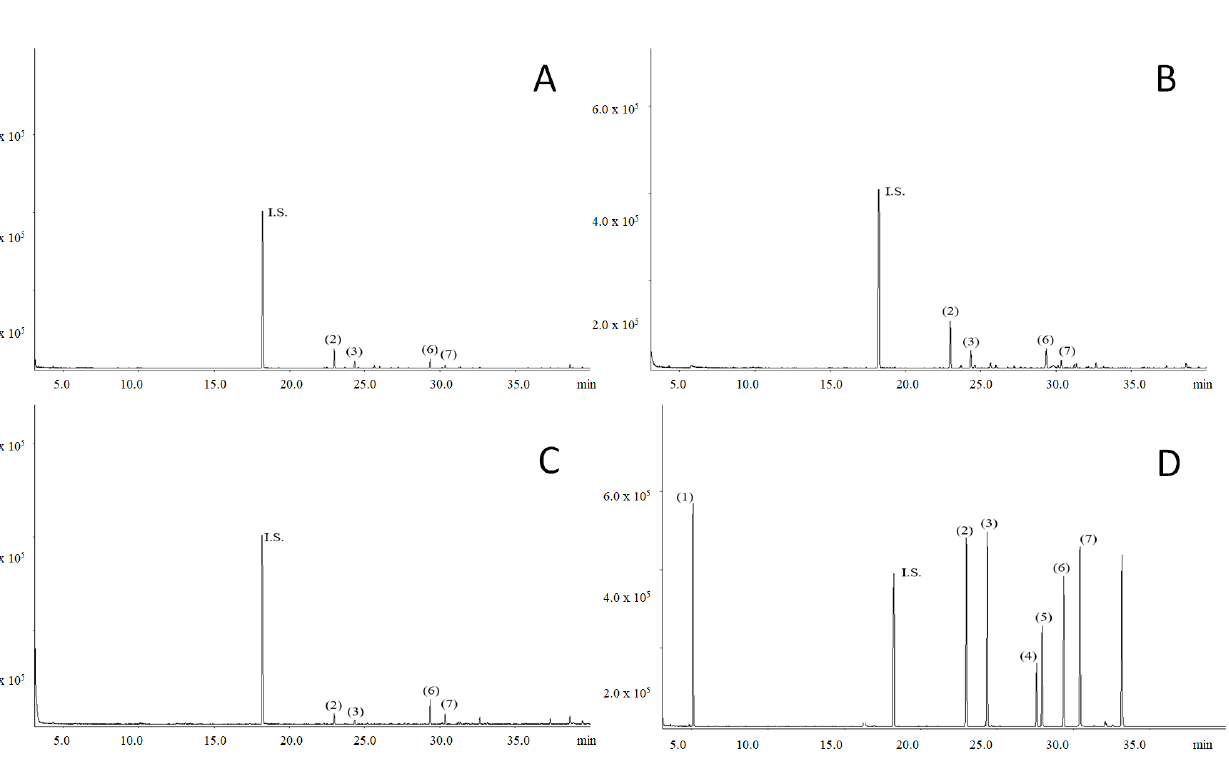
Figure 3. Terpenoid profiles of the investigated hemp samples. I.S.— n -tridecane, 1— α -pinene, 2— β -caryophyllene, 3— α - humulene, 4— Z -nerolidol, 5— E -nerolidol, 6—caryophyllene oxide, 7—guaiol, ( A )—before flowering 2019, ( B )—flowering 2019, ( C )—after flowering 2019, ( D )—after flowering